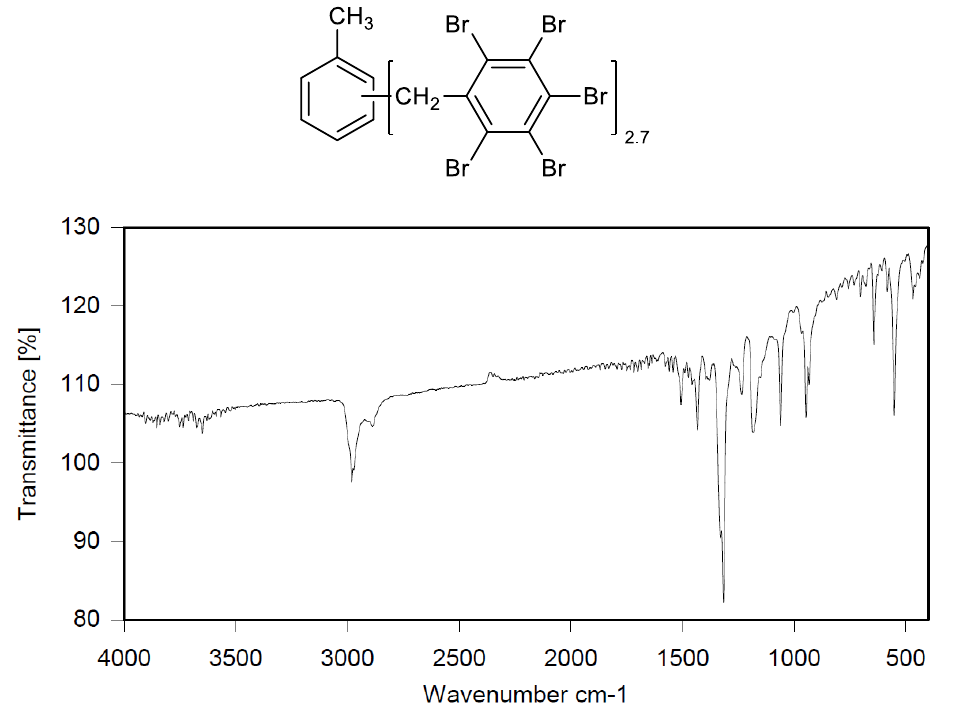
Figure 1. FTIR spectrum of toluene alkylated with entabromobenzyl bromide (T-PBBB).